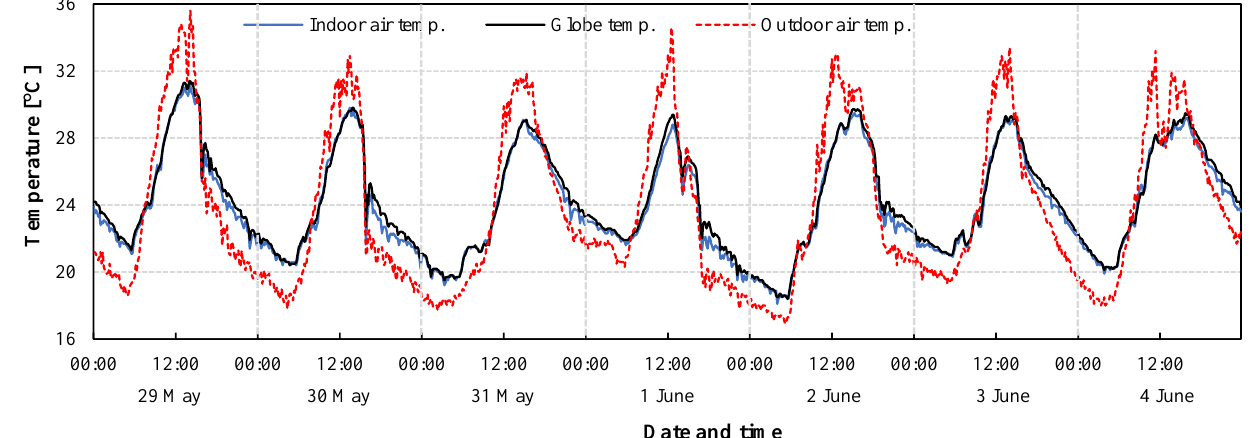
Figure 10. Variation in measured indoor and outdoor temperatures in zone 3 of the S1 school building over a week (2019).